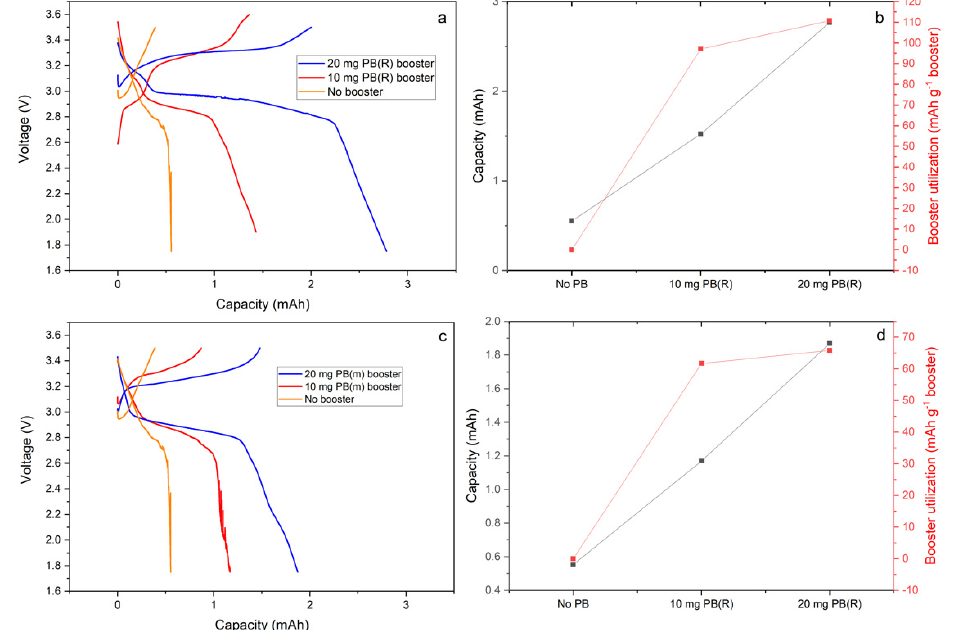
Figure 3. First cycle voltage profile for titanium cells with β -alumina membranes, sodium metal anodes, and 0.01 M NaI/I 2 redox mediator. Showing rhombohedral and monoclinic Prussian blue (PB) booster with different loadings ( a , c ) with the corresponding PB booster utilization and cell capacity ( b , d ).